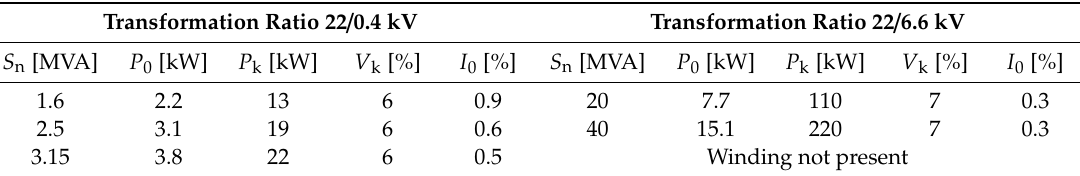
Table 3. Electrical data of the MV / MV and MV / LV transformers.